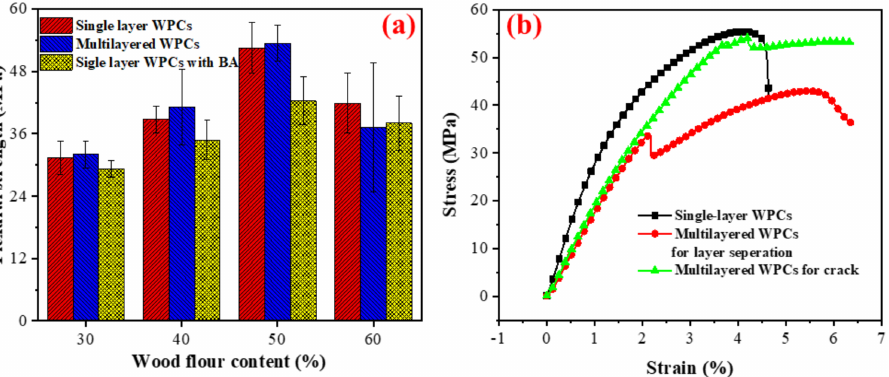
Figure 9. ( a ) Flexural strength of the resulting composites and ( b ) the strain-stress plot of the resulting composites with 50% wood flour